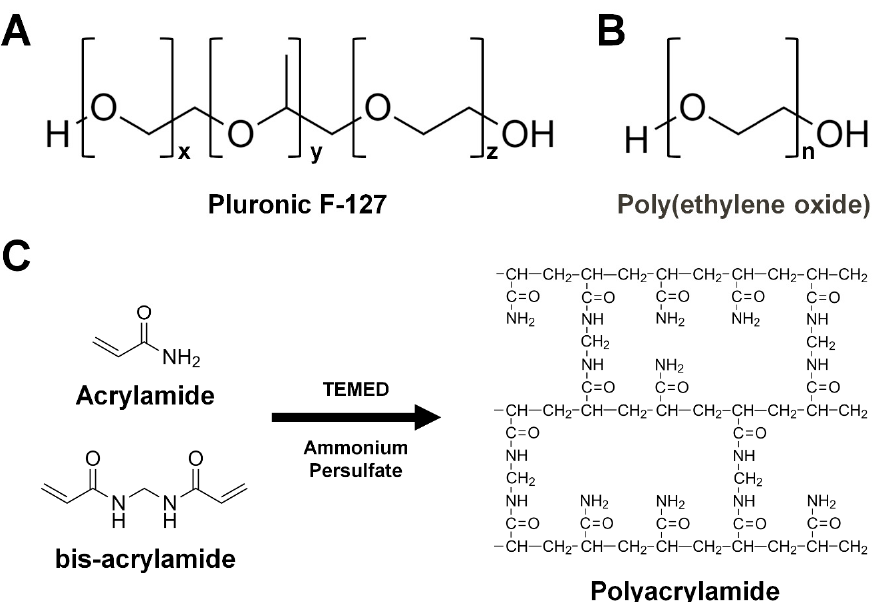
Figure 7. Chemical structure of polymer-based hydrogels. ( A ) Pluronic F-127. ( B ) Poly(ethylene oxide). ( C ) Polyacrylamide. Acrylamide and bis-acrylamide polymerize into polyacrylamide by adding the Tetramethylethylenediamine (TEMED) and ammonium